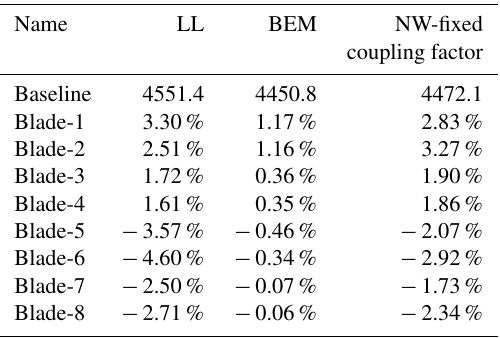
Table 4. The aerodynamic power (in kW) of the baseline straight blade and the relative difference in aerodynamic power (in %) of the different swept blades with respect to the baseline blades calcu- lated using different aerodynamic models. The operational condi- tion has a uniform wind speed of 8ms − 1 and a rotational speed of 0.855rads − 1 .